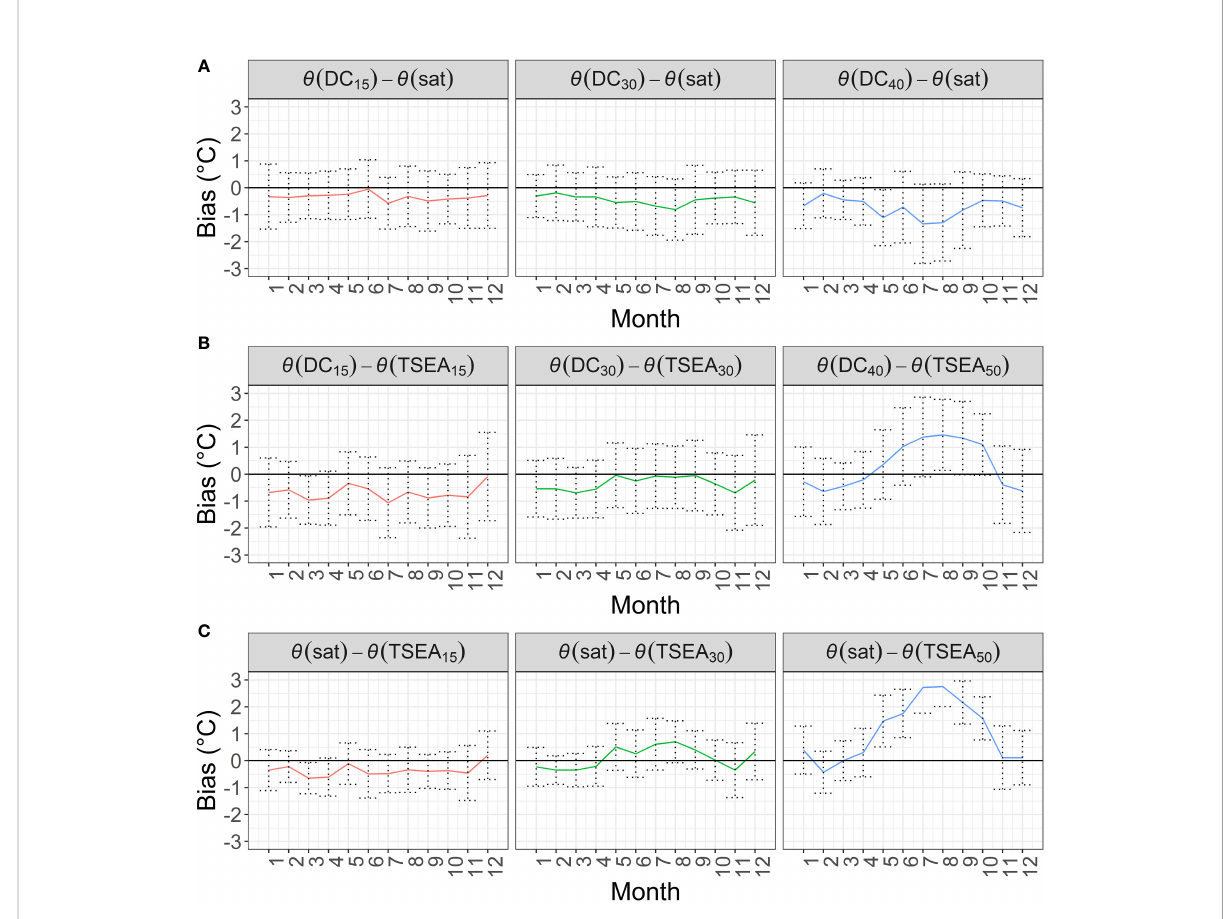
FIGURE 8 Mean bias by depth and month for (A) q (DC) - q (sat), (B) q (DC) - q (TSEA), (C) q (sat) - q